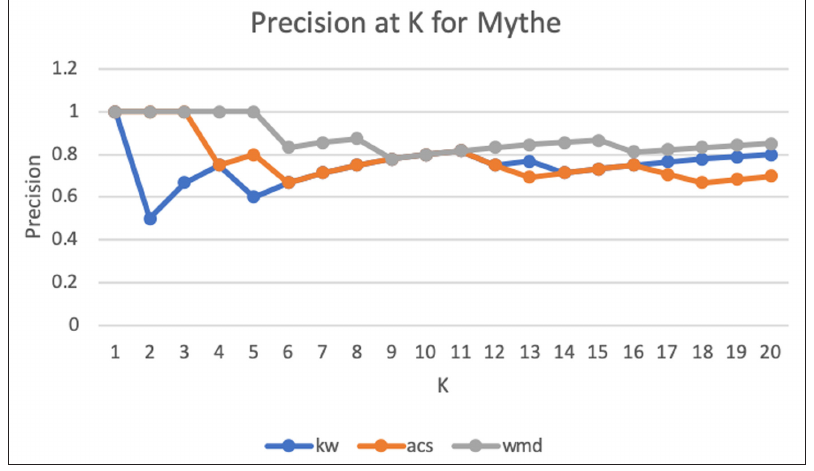
Figure 6: P@K for